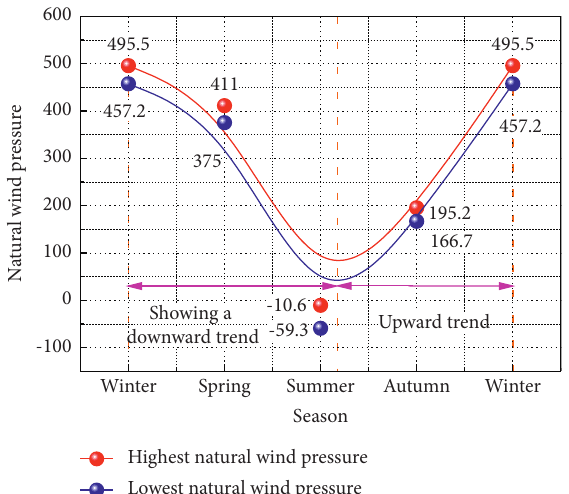
Figure 6: Change of natural wind pressure in south wing shaft area of tangkou coal mine.